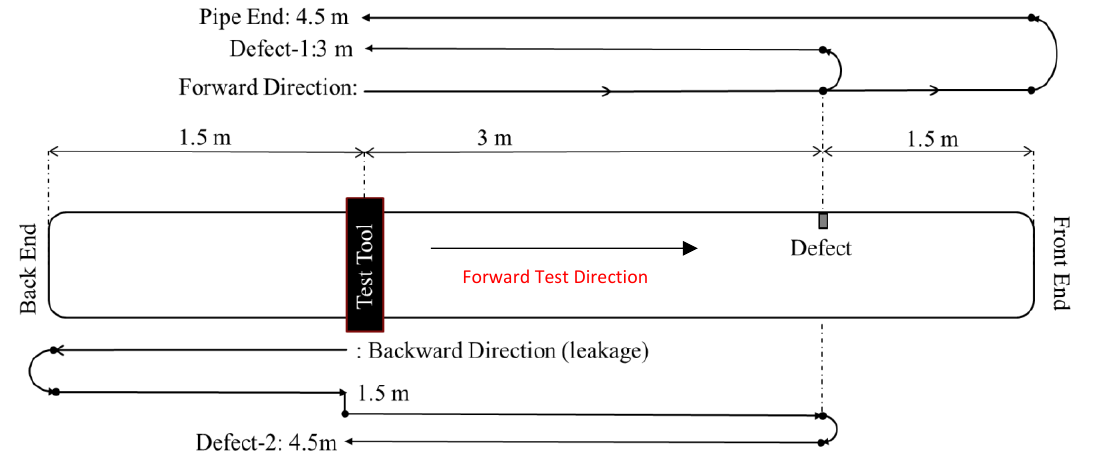
Figure 10. Torsional mode reception route for laboratory trials.